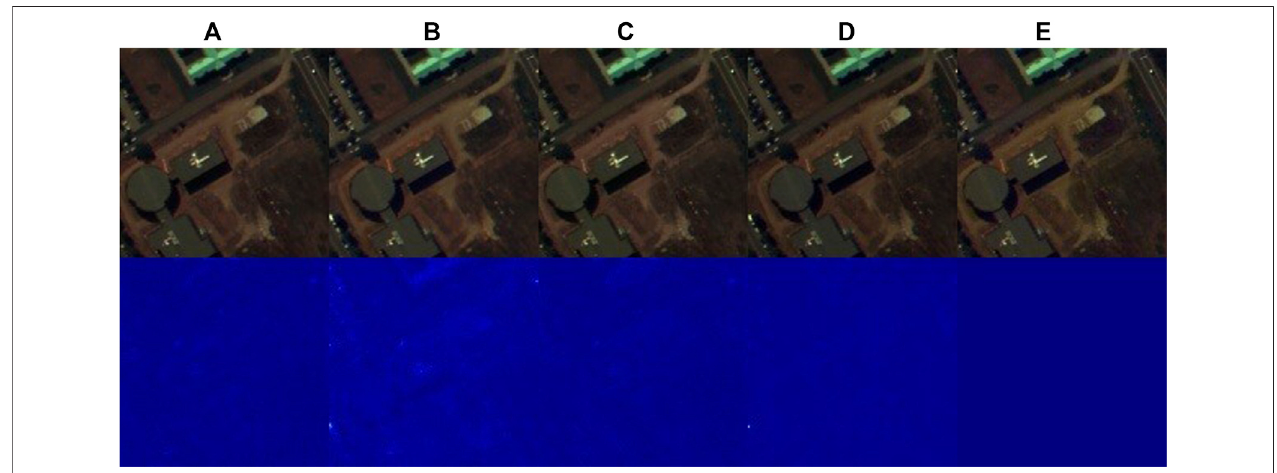
FIGURE6| QualitativecomparisononPaviaUniversitydatasetincaseofsingleinputHRMSIandType2spectraldownsampling.Forvisualizationpurposes,three spectral bands (66-28-0) are selected from the output data and difference images are calculated based on that preselected three bands. The fi rst row shows (A)